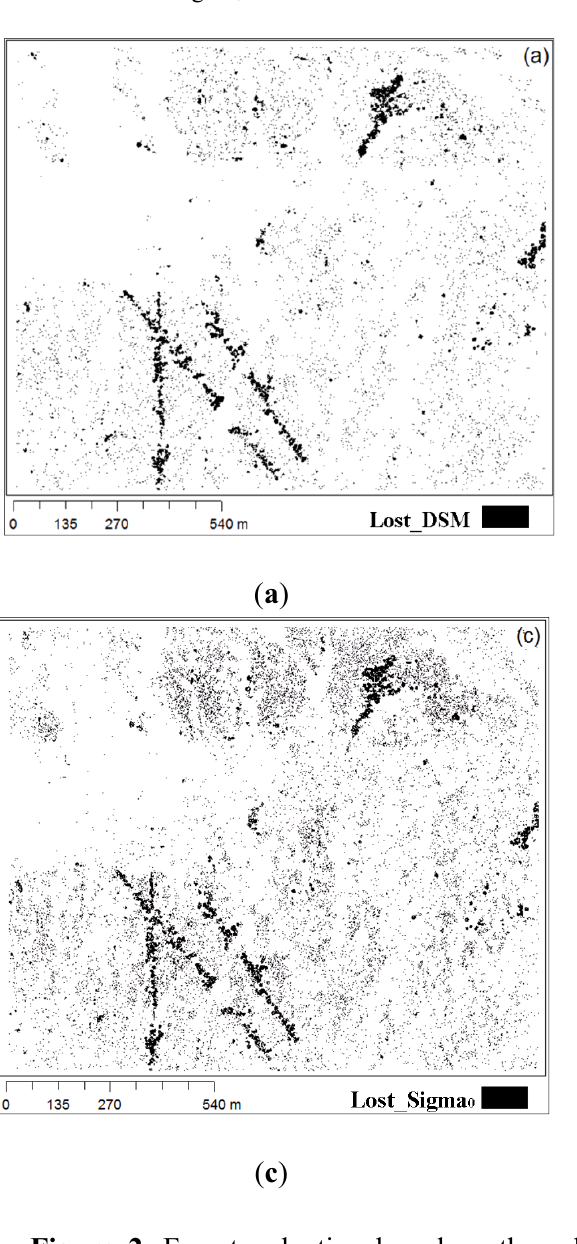
Figure 2. Forest reduction based on the selected thresholds for the ( a ) DSM; ( b ) sER; ( c ) Sigma 0 ; and ( d ) Knowledge-based